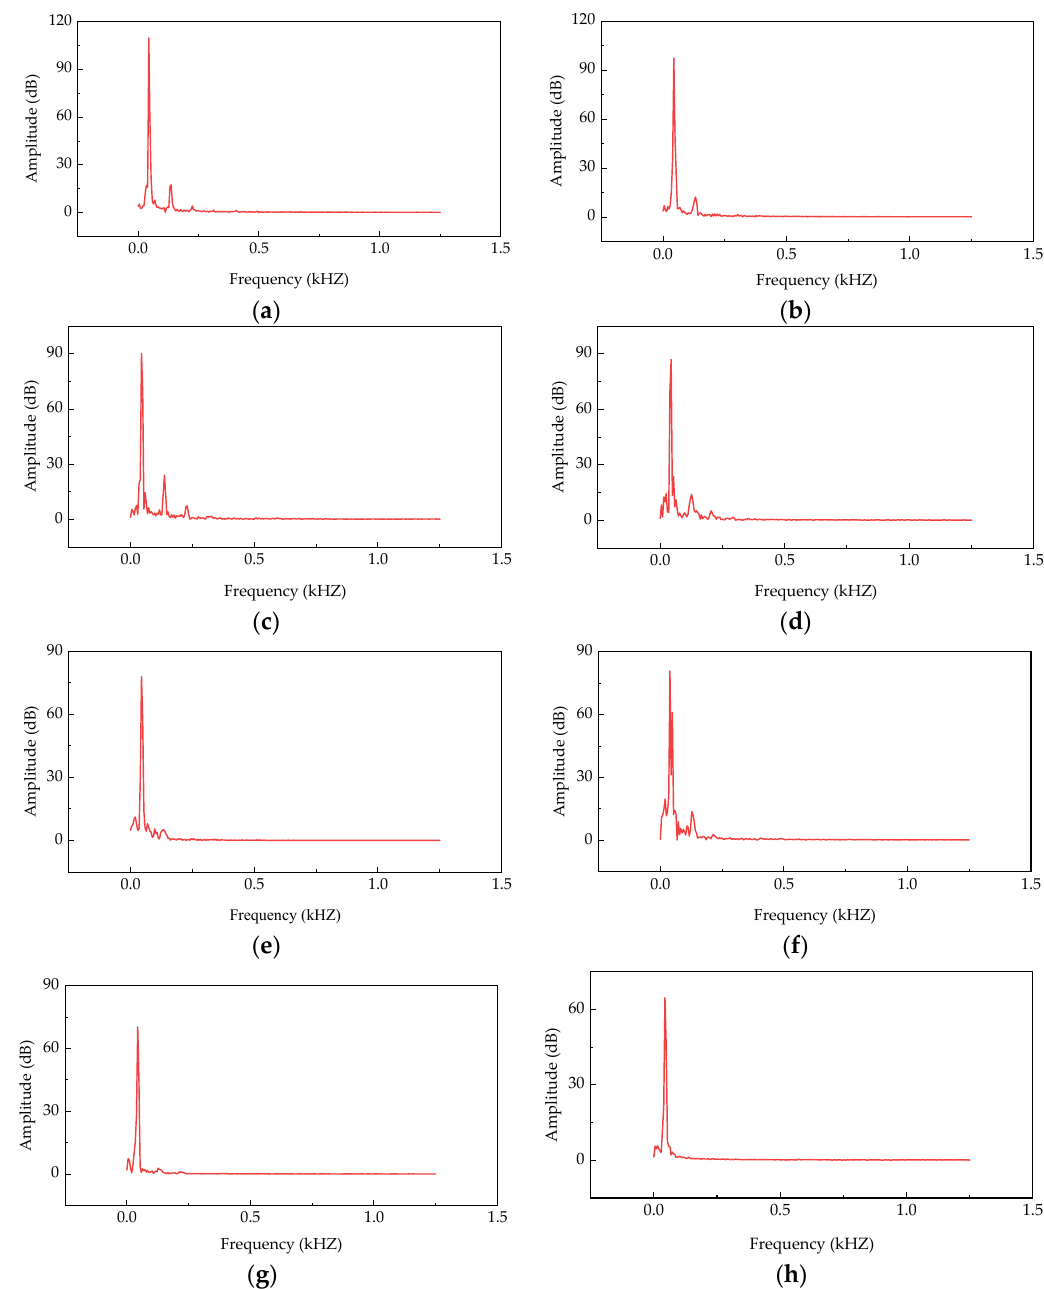
Figure 16. Ultrasonic testing results of specimens on the 7th day: ( a ) 5-SR-0; ( b ) 5-SR-25; ( c ) 5-SR-50; ( d ) 5-SR-75; ( e ) 5-SR-100; ( f ) 4-SR-50; ( g ) 3-SR-50; and ( h ) 2-SR-50 specimens.